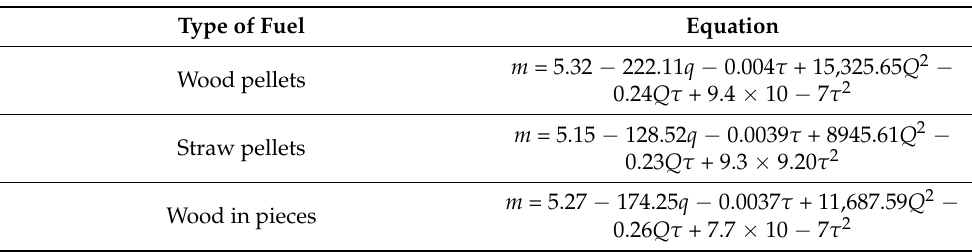
Table 4. The empirical equations of the influence of the air supply and of the gasifier run time on the fuel mass that remained in a